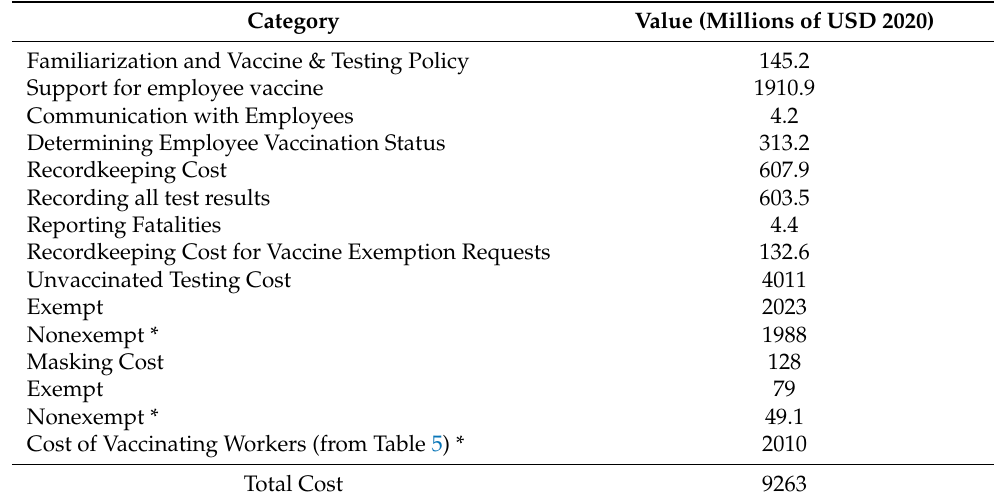
Table 6. OSHA’s COVID-19 Vaccination and Testing ETS, including all Testing and Vaccine